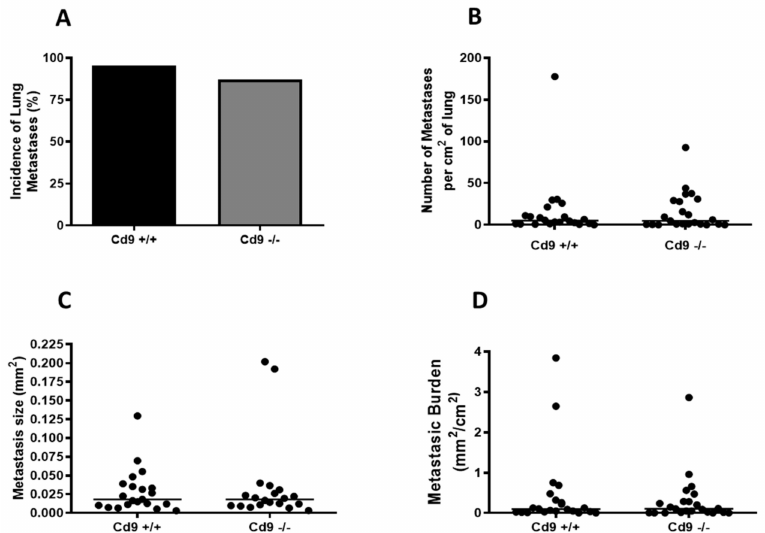
Figure 6. Cd9 deletion has no significant e ff ect on pulmonary metastasis in the MMTV / PyMT breast cancer mouse model. Pulmonary metastasis was assessed in PyMT Cd9 +/+ and Cd9 − / − mice at 12–14 weeks of age. ( A ). Incidence of lung metastases in PyMT Cd9 − / − and Cd9 +/+ mice. ( B ). Number of metastases per mouse in PyMT Cd9 +/+ and Cd9 − / − mice. ( C ). Metastasis size in PyMT Cd9 +/+ and Cd9 − / − mice. ( D ). The metastatic burden of PyMT Cd9 +/+ and Cd9 − / − mice at 12–14 weeks of